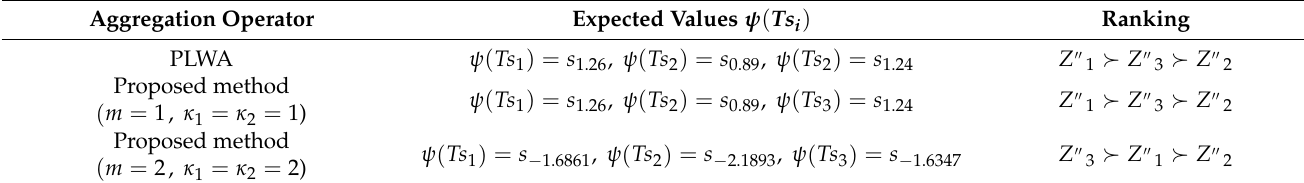
Table 5. Comparison using two